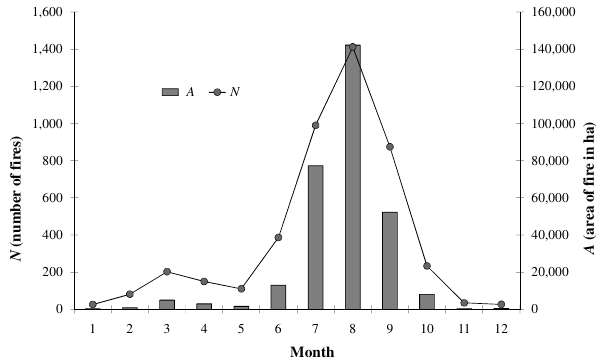
Fig. 2. Monthly average of burnt area, A , (grey bars) and of number of fire occurrences, N , (solid line) in continental Portugal for the 1980–2005 period.